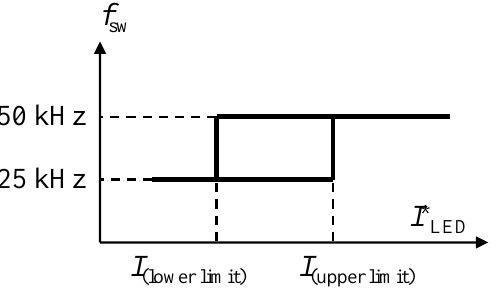
Figure 30. Relationship between the LED reference current and the switching frequency.